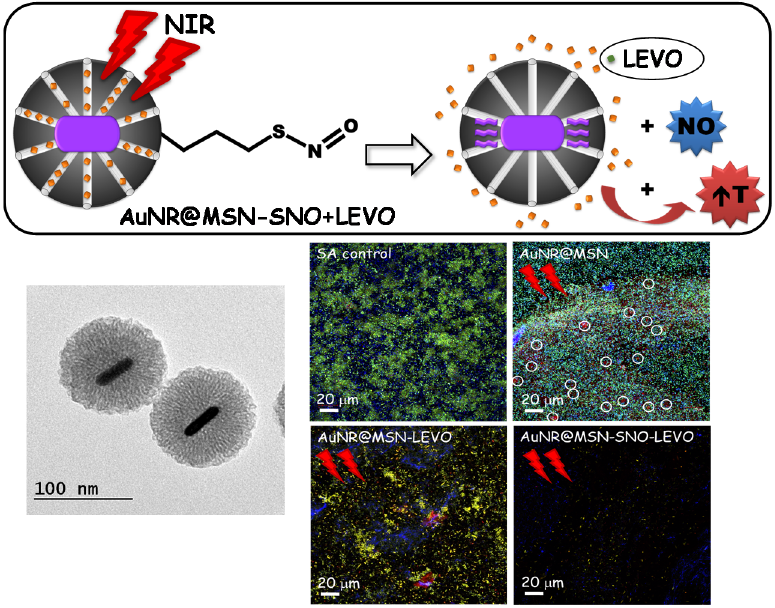
Figure 9. Top image: schematic representation of the nanocarrier design AuNR@MSN-SNO+LEVO and its effect on a S. aureus biofilm in response to near infra-red (NIR) laser treatment. Bottom left image: transmission electron microscopy micrographs of AuNRs surrounded by a mesoporous silica shell of AuNR@MSN-PEG ext nanocarriers. Bottom right: confocal microscopy images of the antimicrobial action of AuNR@MSN nanocarriers onto Gram-positive S. aureus (SA) biofilm. These images depict the biofilm preformed without treatment (SA CONTROL), and after incubation with AuNR@MSN, AuNR@MSN+LEVO and AuNR@MSN-SNO+LEVO nanocarriers with subsequent NIR treatment. Live bacteria are stained in green, dead bacteria in red, ablation zones are marked with white circles, and the extracellular polysaccharide matrix biofilm is stained in blue. Adapted with permission from Garc í a et al. [165], Micropor. Mesopor. Mat., published by Elsevier,